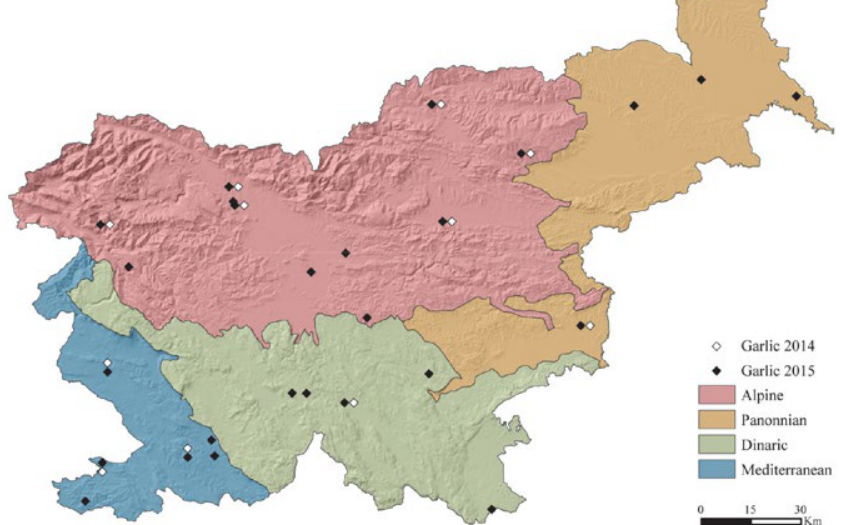
Fig. 1. Regionalization of Slovenia into four macro-regions 23 with sampling sites and years of garlic